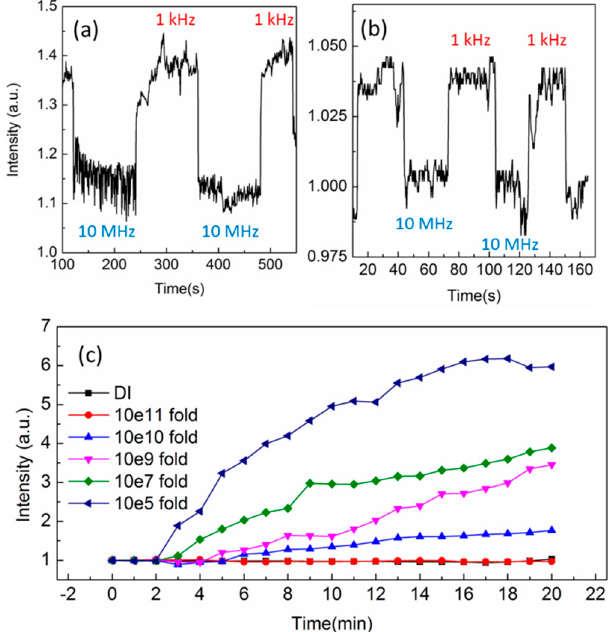
Figure 3. ( a ) The transmission intensity for 3 μ m polystyrene beads tested by switching repeatedly from 1 kHz to 10 MHz frequency under 6 V voltage; ( b ) The transmission intensity for 0.1 μ m polystyrene beads; ( c ) The transmission intensity as a function of time for different concentration. The particles were 1.36 μ m PMMA beads.